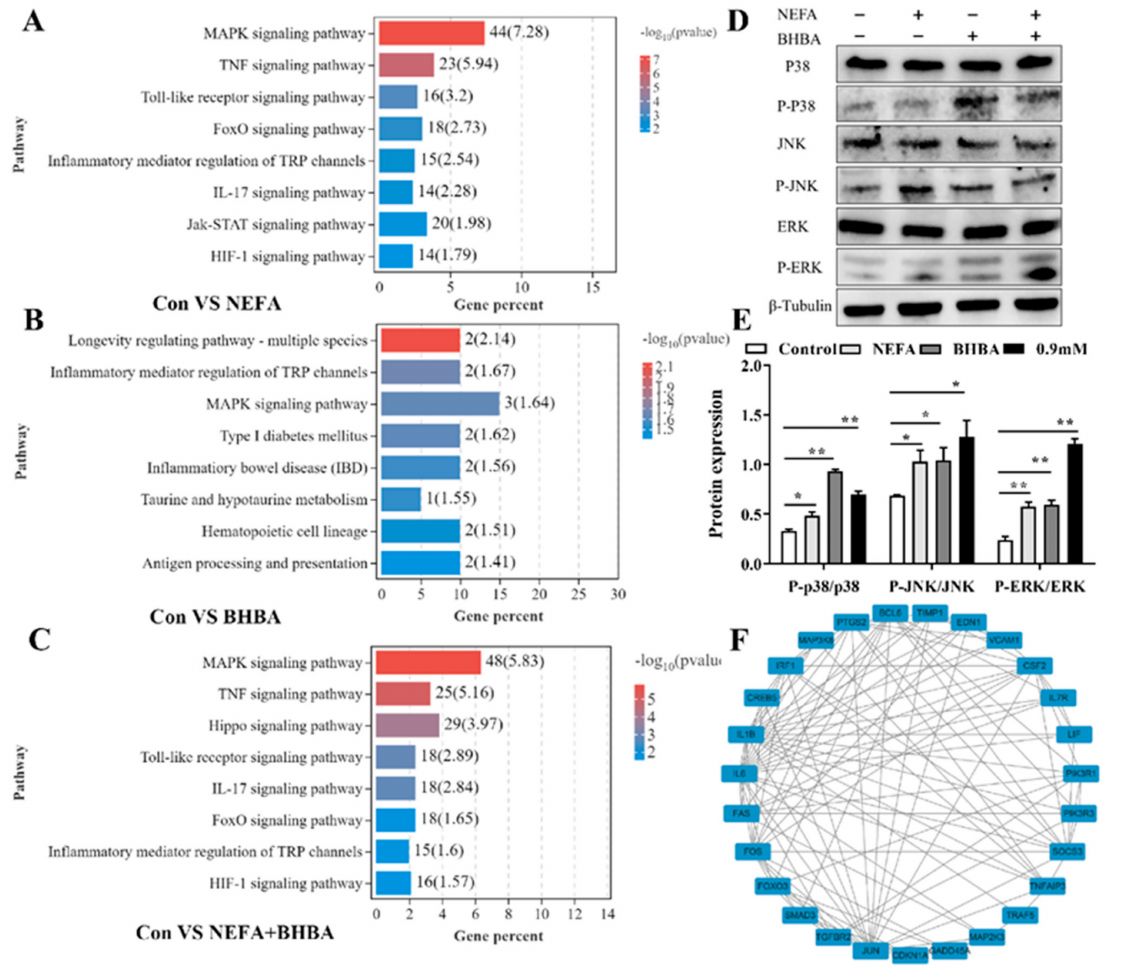
Figure 5. MAPK Pathway was activated by NEFA and BHBA. ( A – C ) KEGG enrichment analysis of DEGs in BMECs treated with NEFA and BHBA. ( D , E ) Protein expression of MAPK pathway-related genes in BMECs treated with NEFA and BHBA. ( F ) PPI network of differentially expressed genes selected in the MAPK and TNF signaling pathway. Data are presented as the means ± SEM of three independent experiments. * p < 0.05; ** p <